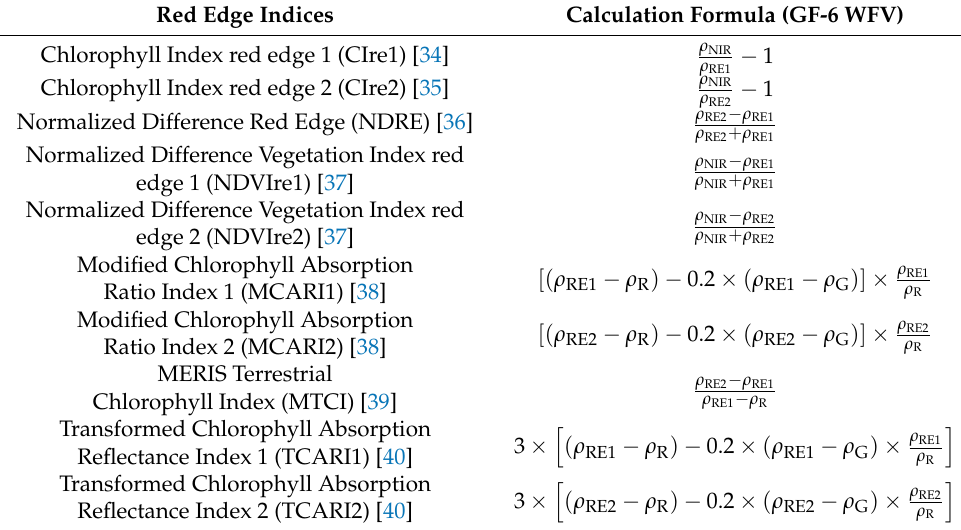
Table 5. Ten different red edge vegetation indices based on GF-6 WFV